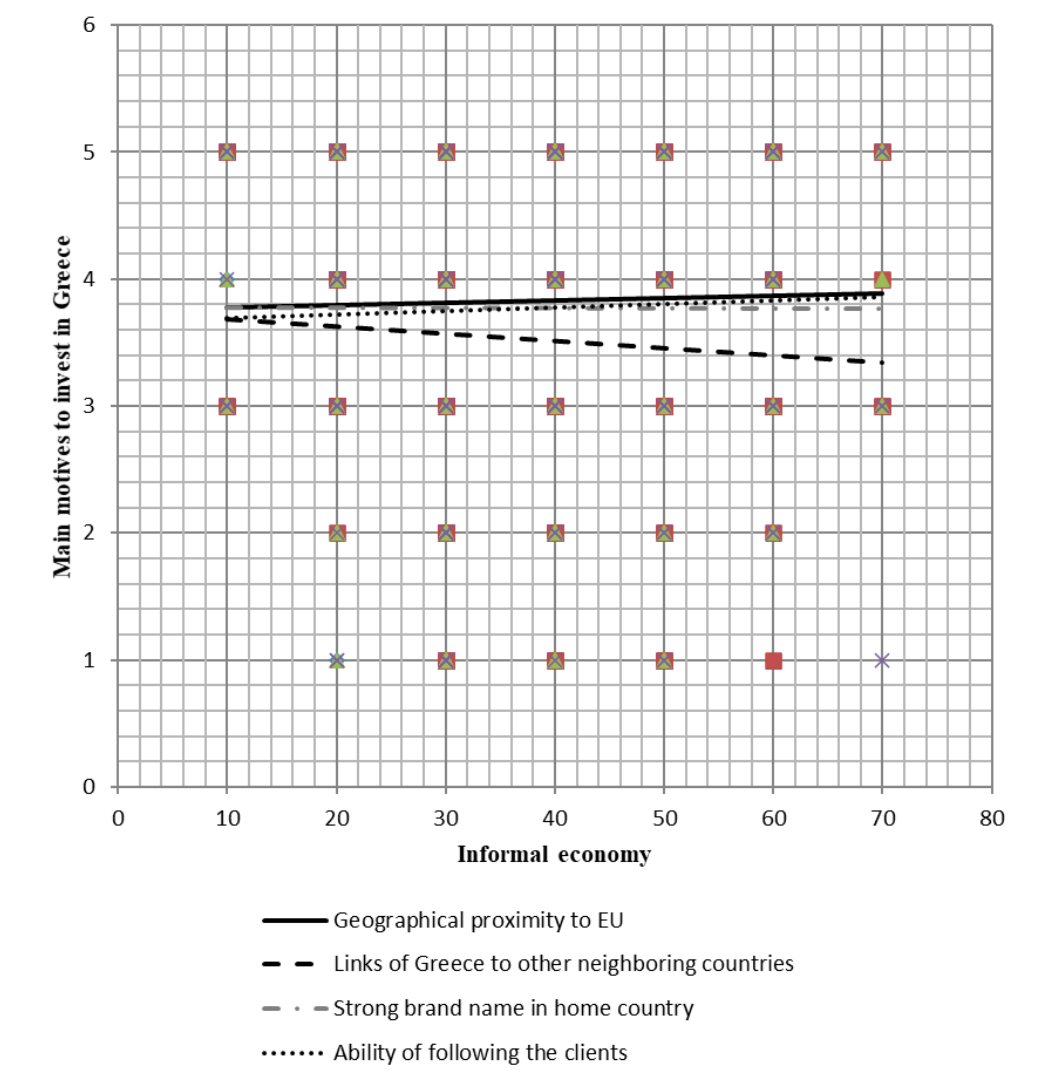
Figure 2: Main Motives to Invest in Greece and the Informal